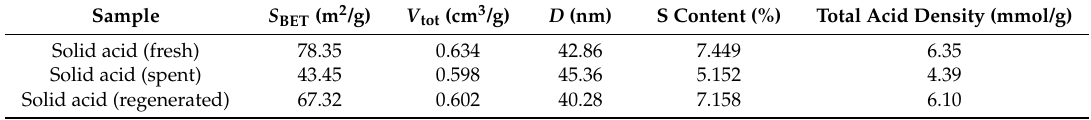
Table 4. Textural properties, S content and total acid density of the samples 1